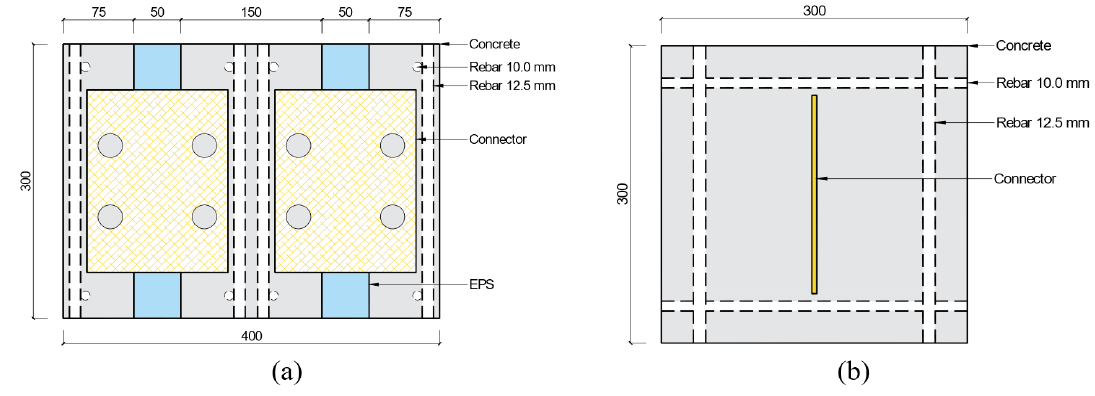
Figure 6. Test specimen: (a) front view; (b) side